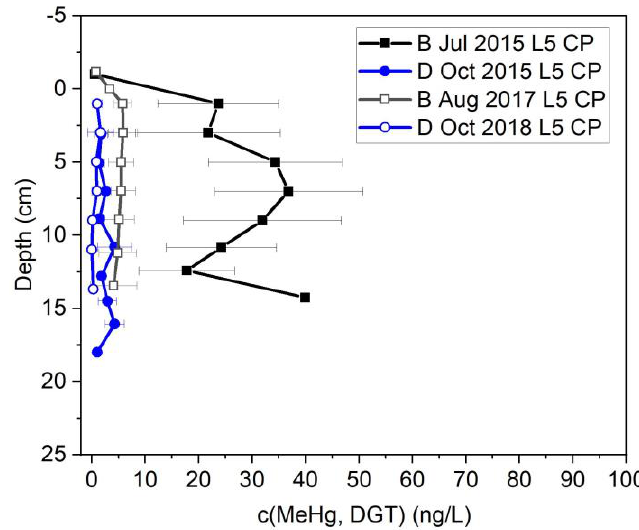
Figure 8. Porewater MeHg concentration measured by DGT in L5 at Constitution Park during sampling events before and after bank stabilization and during baseline (B) and drainage (D); on the y-axis, 0 represents the water/sediment interface and the negative numbers refer to distances above the interface (i.e., in the water column).